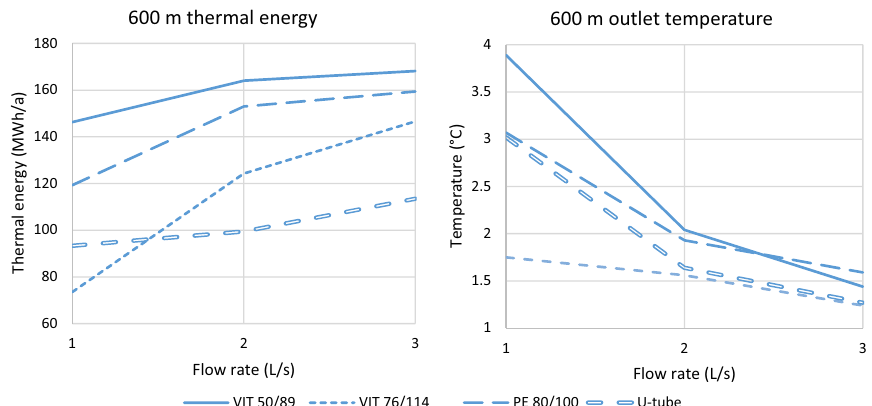
Fig. 6 Thermal energy and outlet temperature from 600-m wells as a function of flow rate with four different